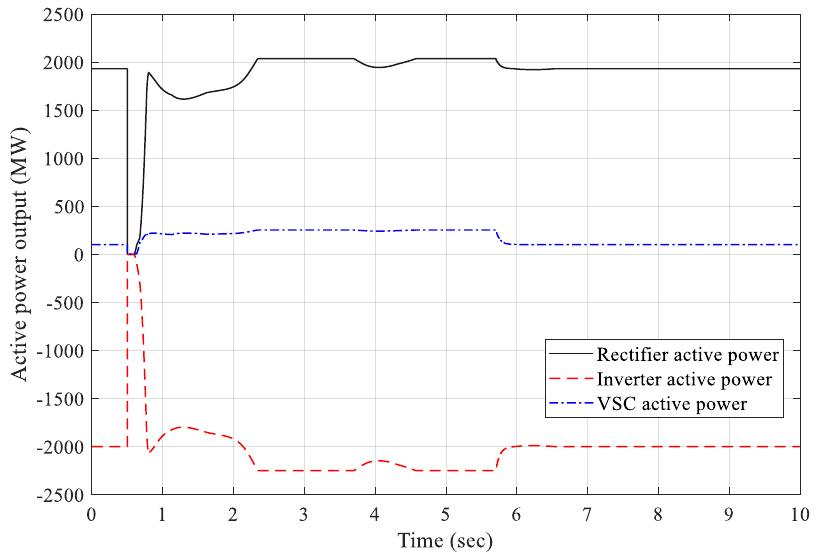
Figure 26. The active power outputs of the overload operation in the actual system data.